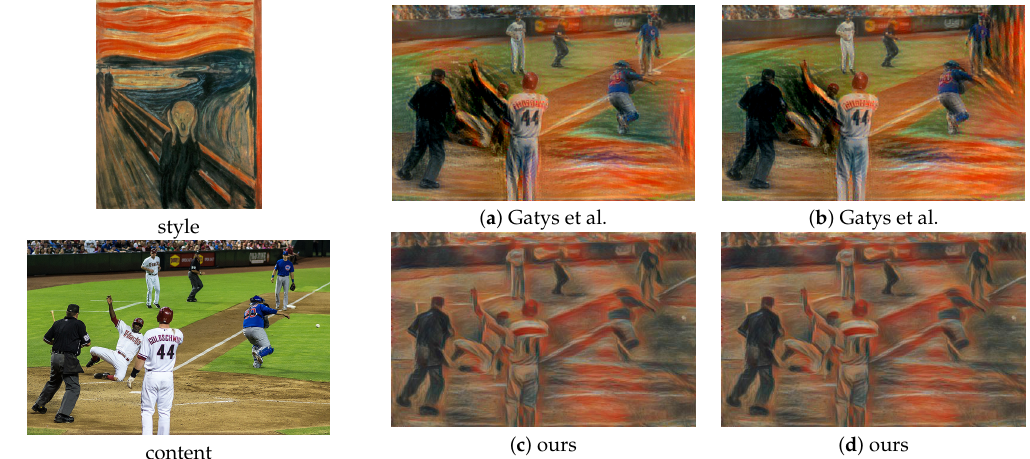
Figure 6. Results from random